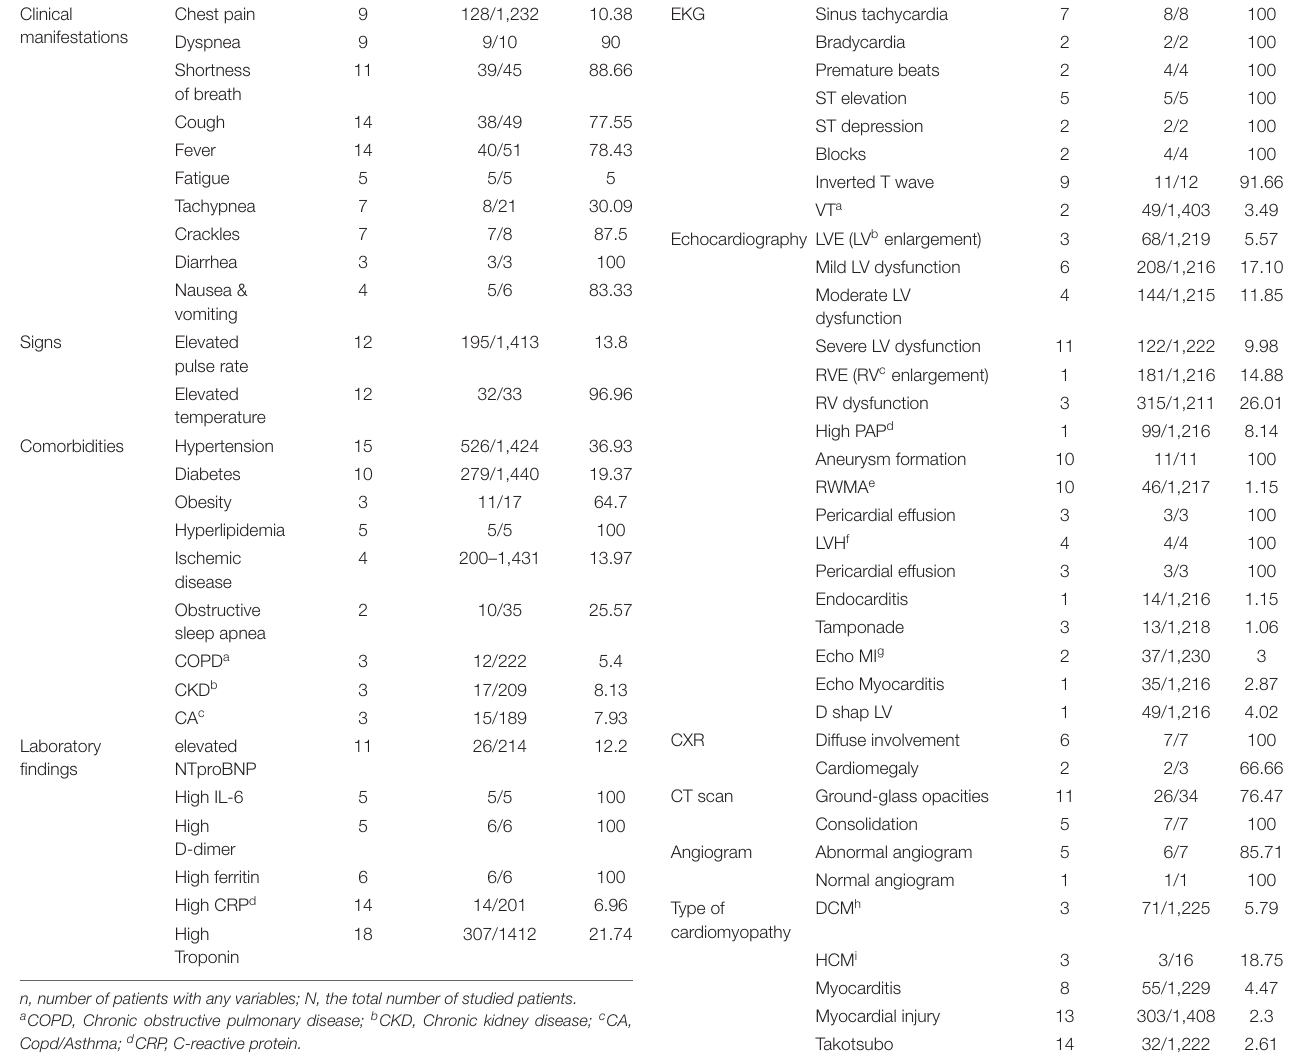
TABLE 4 | Cardiomyopathy evidence in patients with COVID-19.